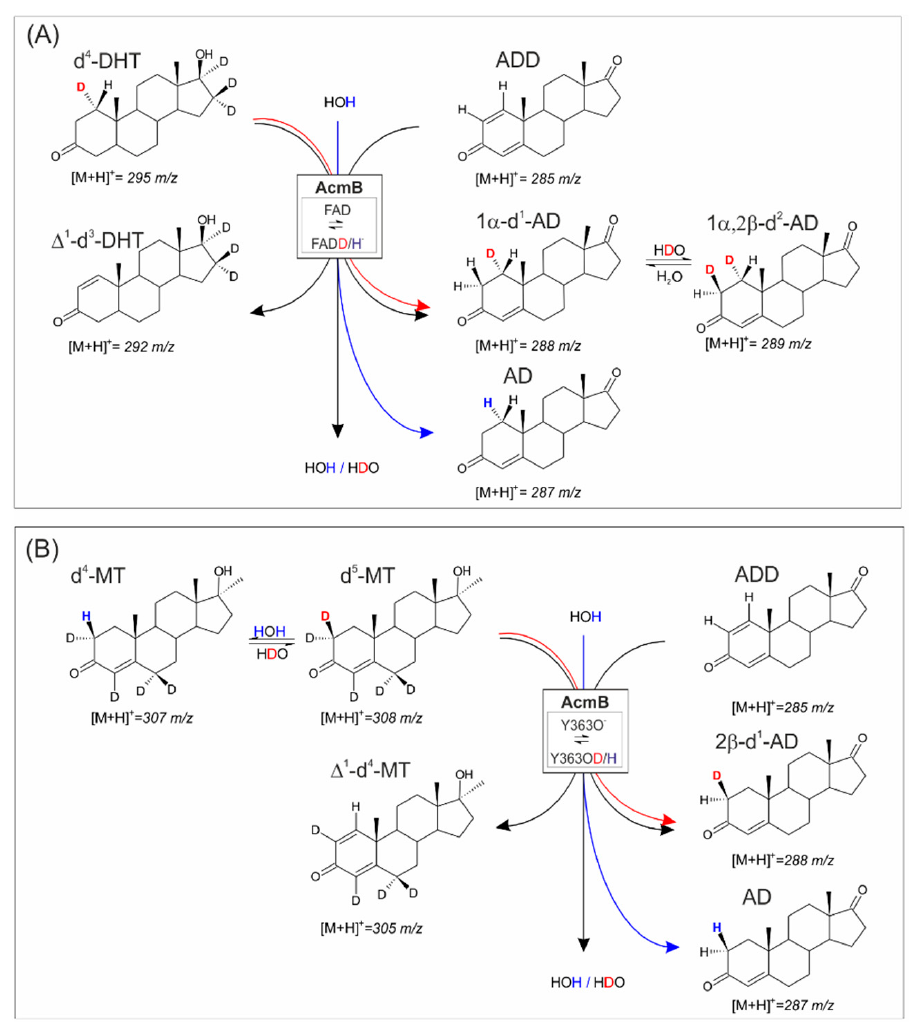
Figure 4. Scheme of transhydrogenation catalyzed by AcmB between ADD and deuterium-labelled substrates: ( A ) d 4 -dihydrotestosterone (d 4 -DHT), substituted at the 1 α position, ( B ) d 5 -17-methyltestosterone (d 5 -MT), substituted at 2 β and 2 α . Red arrows depict the transhydrogenation of deuterium labels, while blue protium was derived from the solvent.